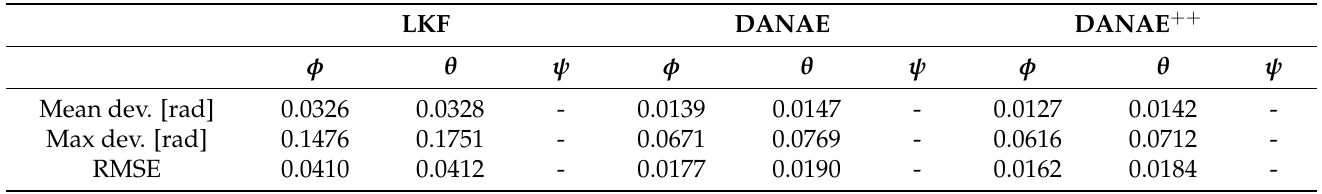
Figure 5. OxIO Dataset: roll angle estimation provided by the EKF (top, light brown) and DANAE ++ (bottom, light blue) compared to the GT (dark red). This experiment is made on a subsection of the slow walking set. Table 4. UCS Dataset: evaluation of the performances of the LKF, DANAE and DANAE ++ w.r.t. the GT for the three Euler angles. Since the GT values of ψ are not reliable, the corresponding results are not reported